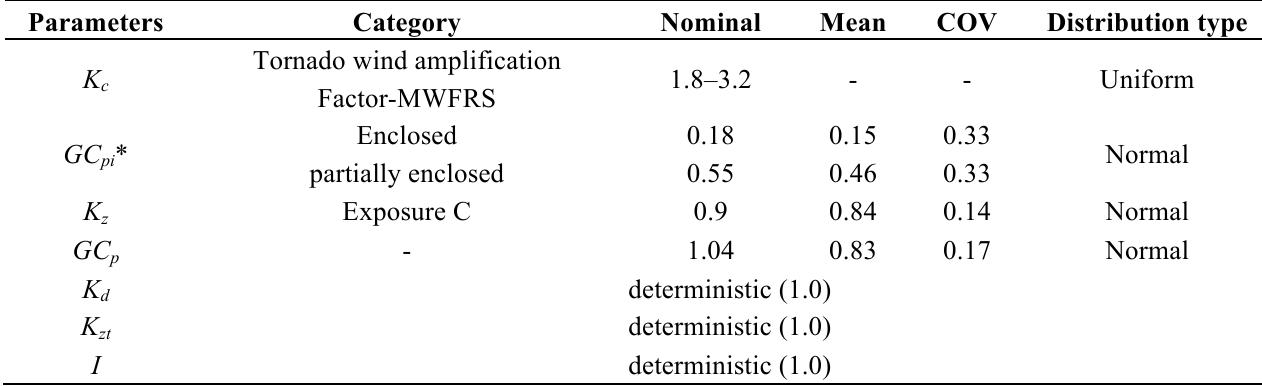
Table 3. Summary of wind load